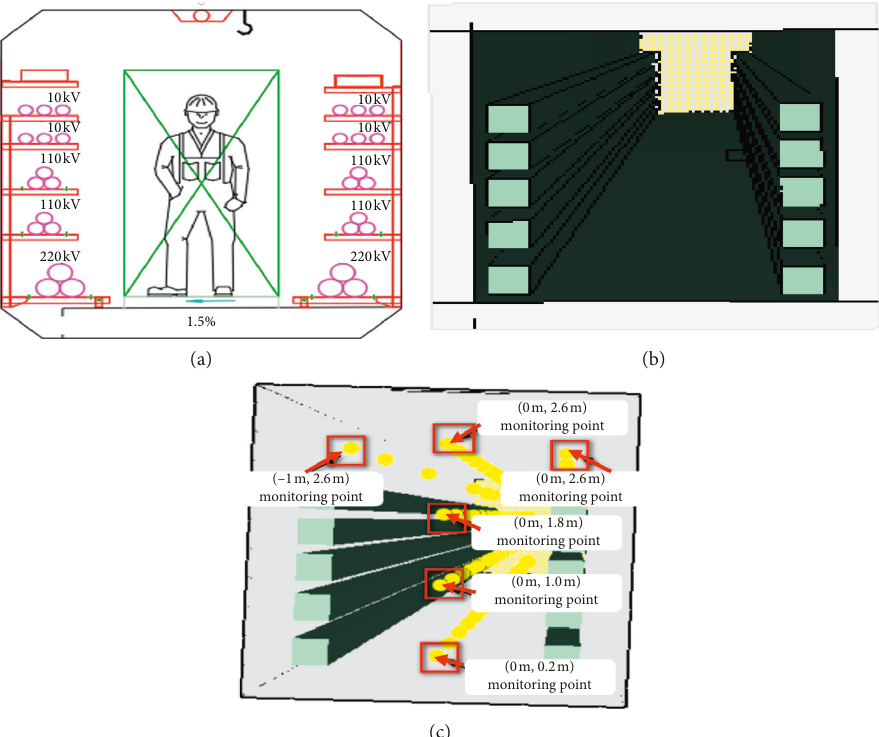
Figure 7: Cross section and simulation model monitoring point. (a) Practical tunnel. (b) Simulation model in FDS. (c) Monitoring points in